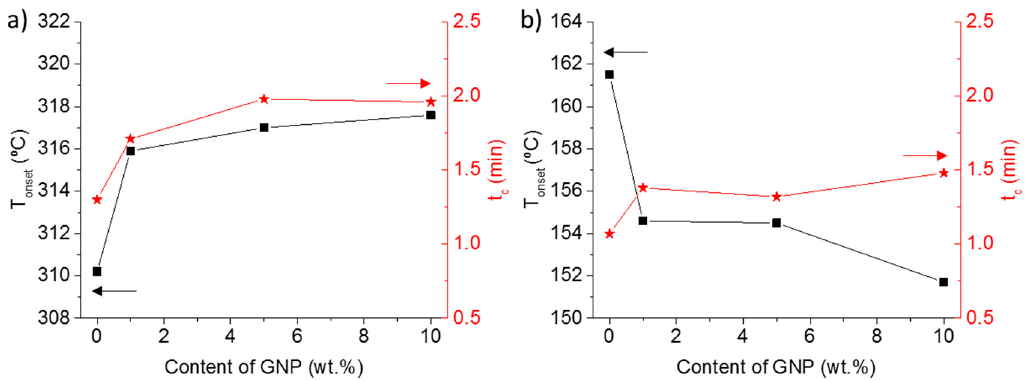
Figure 3. Onset Crystallization temperature (square symbols) and crystallization time (star symbols) against the content of GNP. Samples crystallized from melt ( a ) and from glass ( b ). Crystallization